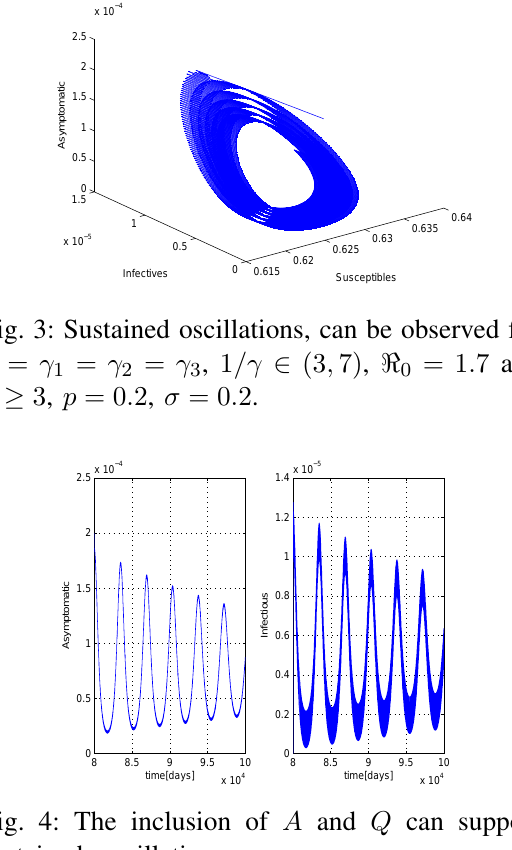
= 1 . 7 and k ≥ 3 , p = 0 . 2 , 0